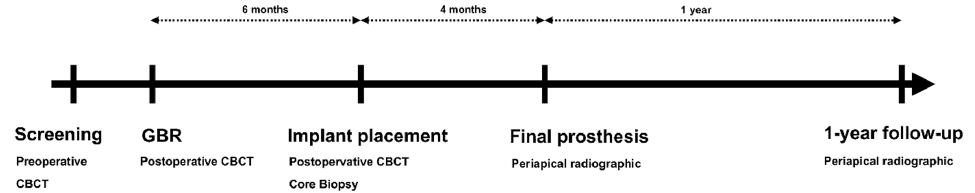
Figure 1. Study design. CBCT, cone-beam computed tomography; GBR, guided bone